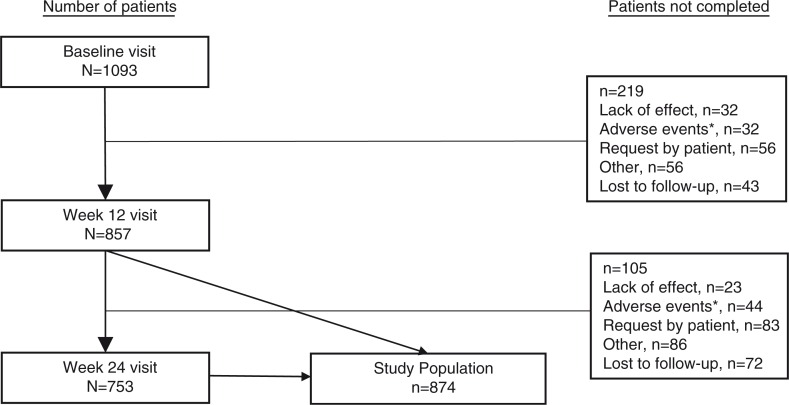
Patient flowchart.